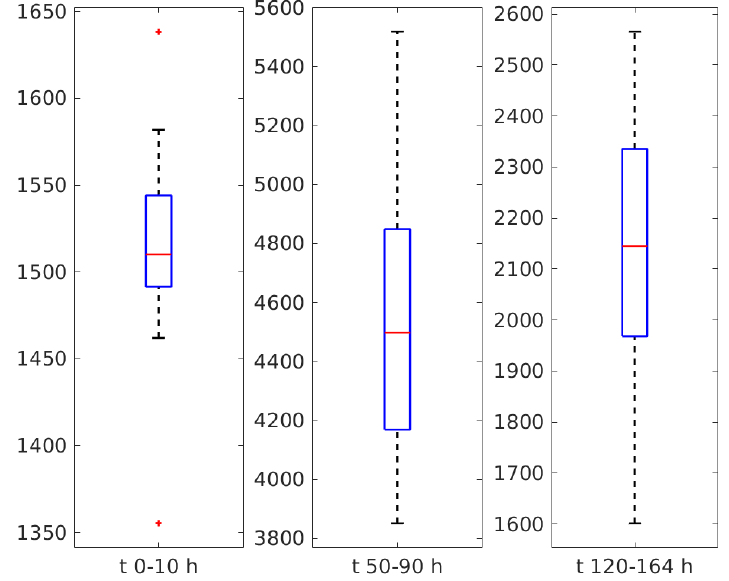
Figure 6. The boxplot of the diameters, in nm, on the three plateaus: 0–10 h, 50–90 h and 120–164 h.